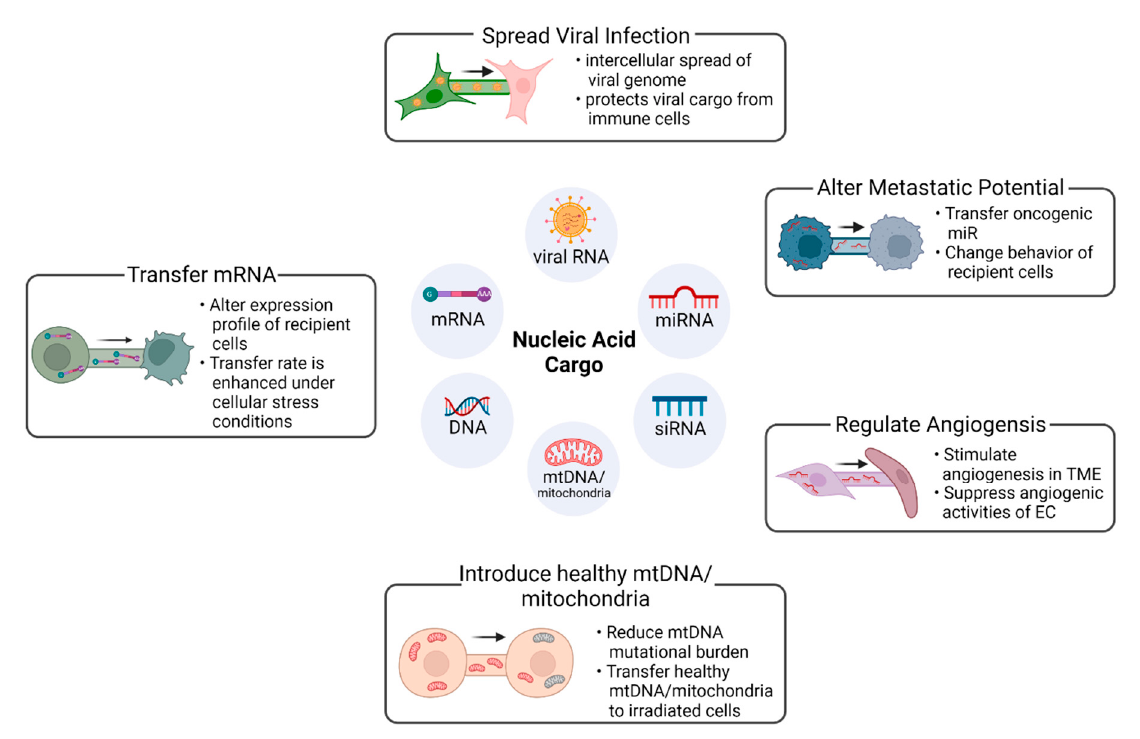
Figure 1. Functional effects of TNT cargo in recipient cells: The TNT-mediated intercellular transfer of nucleic acid cargo has diverse biological effects. This phenomenon is observed in physiological and pathological conditions, and the transfer of cargo can be either bidirectional or unidirectional; the latter mechanism is observed in the spread of several pathological molecules. Abbreviations: EC, endothelial cells; miR, micro RNA; mtDNA, mitochondrial DNA; siRNA, small interfering RNA. TME, tumor microenvironment. This figure was created in BioRender. Table 2. Intercellular nucleic acid transfer via TNTs.